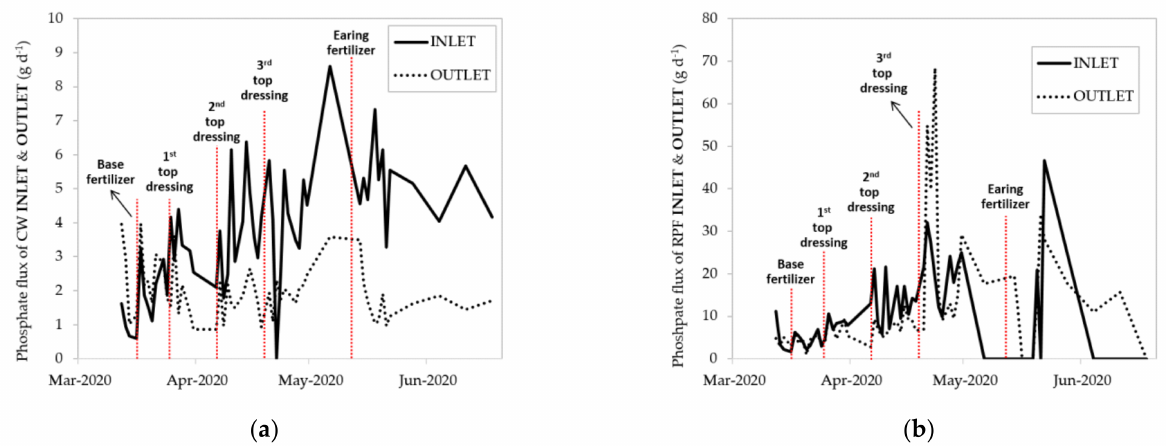
Figure 7. Phosphate fluxes of INLET and OUTLET in ( a ) CW treatment and ( b ) RPF treatment of the first crop season, 2020 (March–June); each fertilization timing is marked. Table 7. The average phosphate fluxes and removal efficiency of each fertilization period. Fertilization